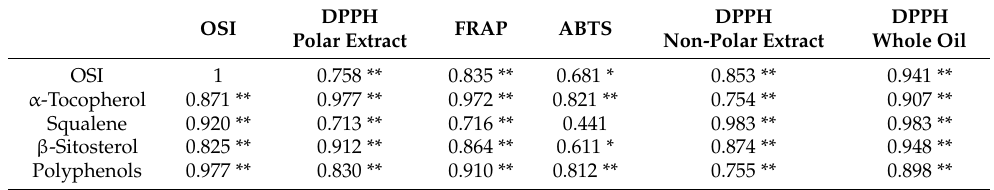
Table 4. Correlations between bioactive compounds, oxidative stability, and antioxidant activity.